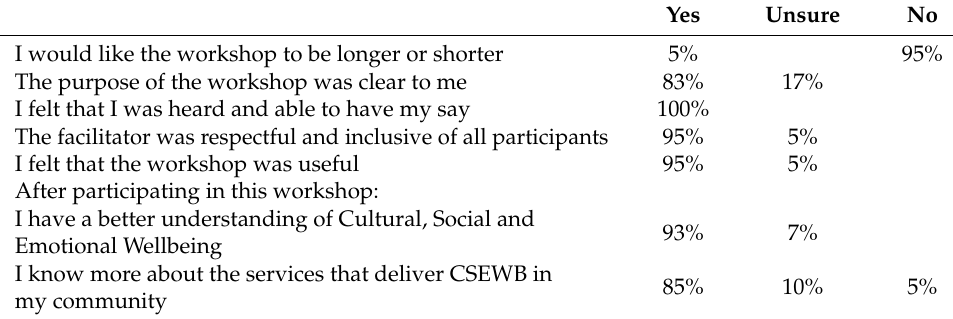
Table 1. CSEWB program